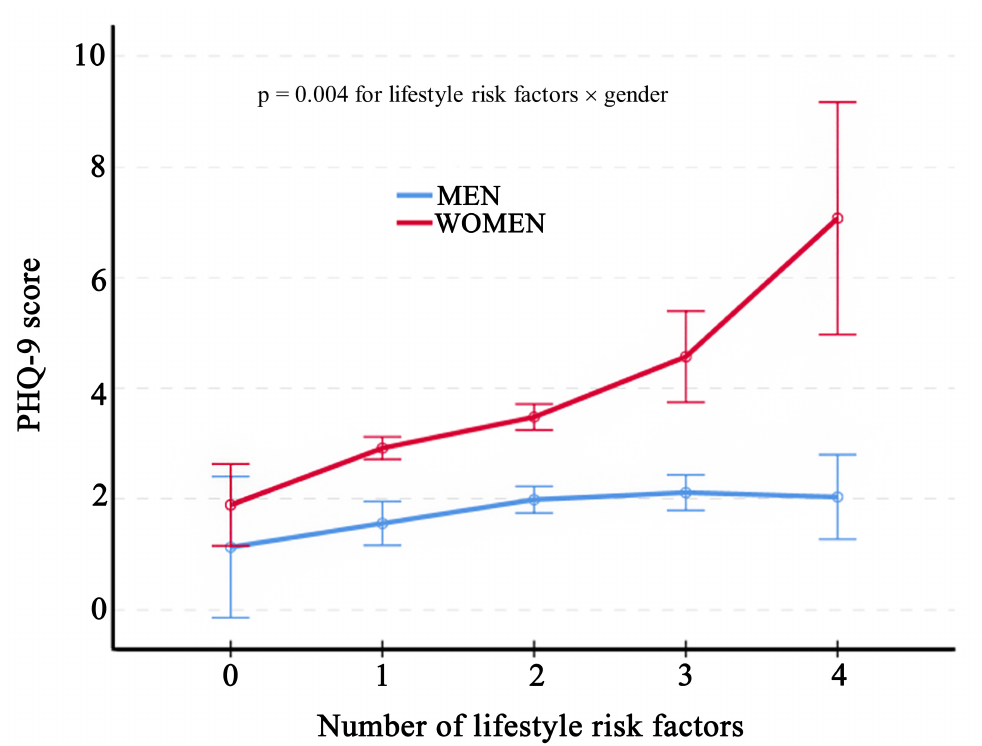
Fig. 2. The relationships between lifestyle risk factors (i.e., smoking, at-risk alcohol consumption, inadequate sleep, physical inactivity) and depression by